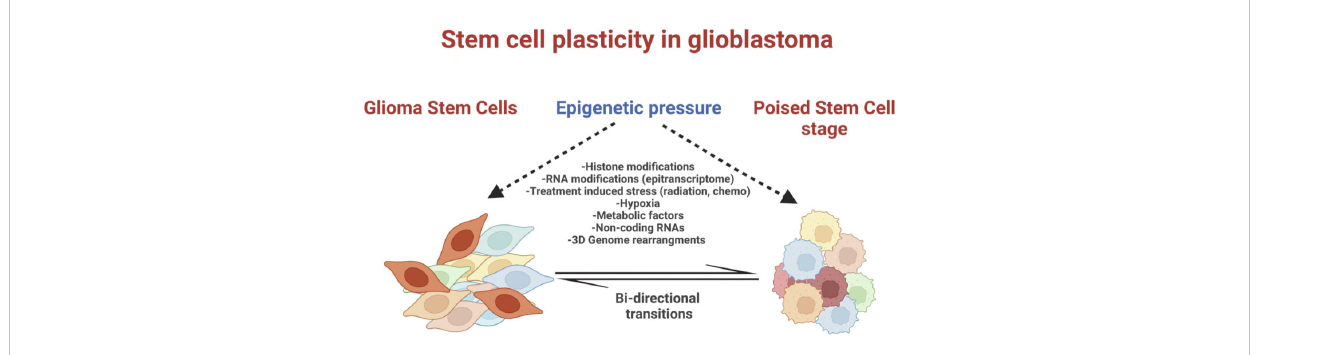
FIGURE 1 Intrinsic and extrinsic epigenetic pressure maintains GBM cells at an adaptive or "poised" stem cell